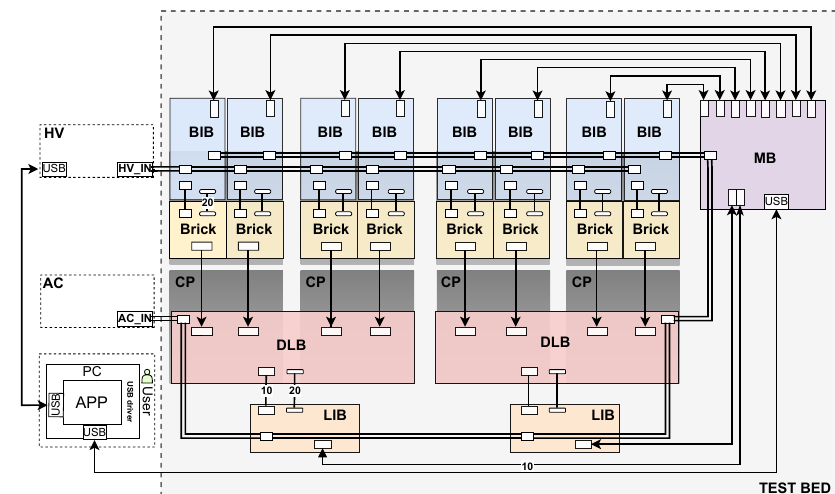
Figure 7. Functional block diagram illustrating the burn-in station